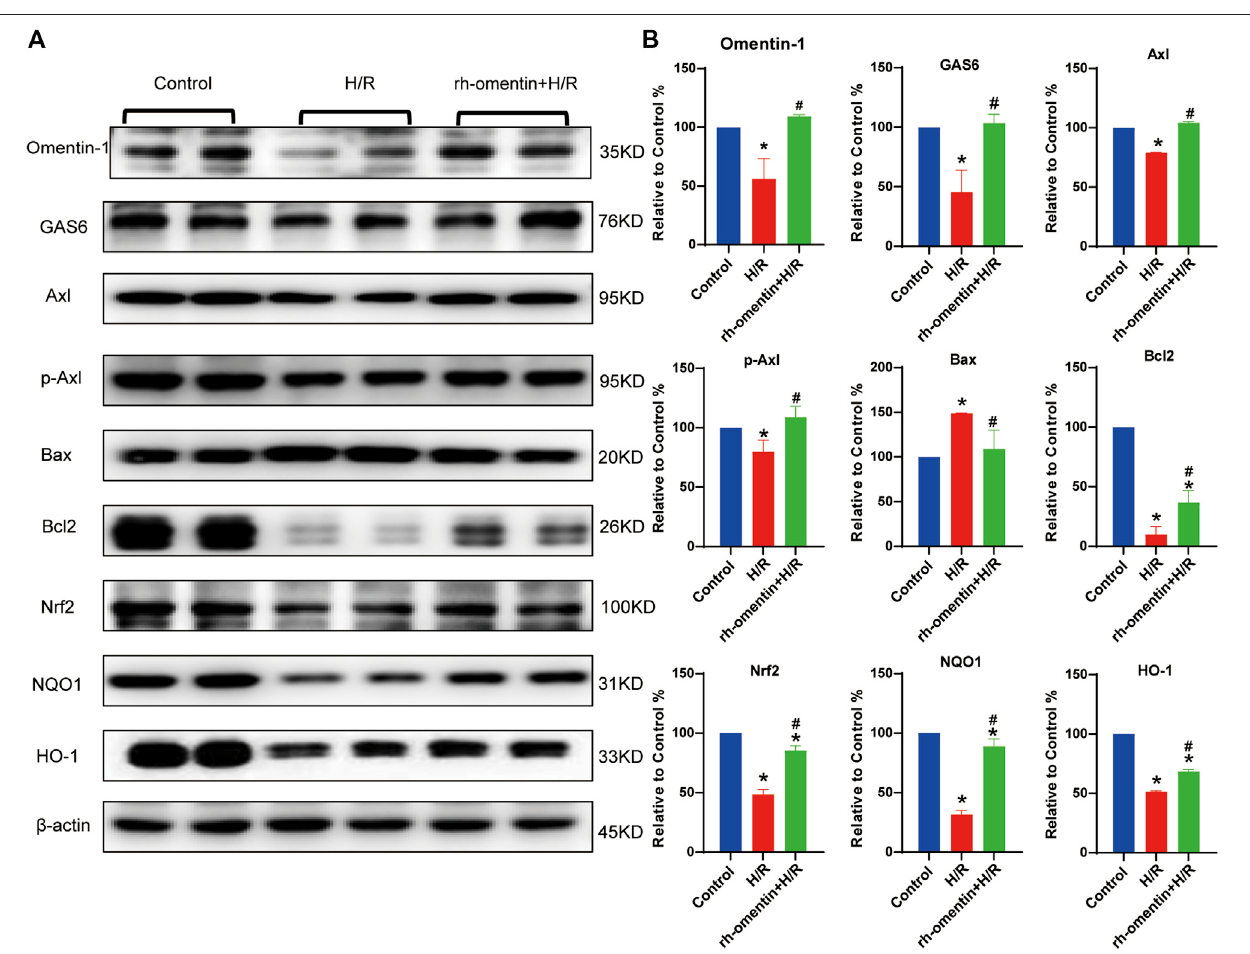
FIGURE 5 | Effect ofrh-omentintreatment onoxidative stressmolecules,apoptotic molecules, and GAS6/Axlsignaling molecules inN2a cells injured byH/R. (A) The representativeimagesofOmentin-1,GAS6,Axl,p-Axl,NQO1,HO-1,Nrf2,Bax,andBcl2detectedbyWesternblot. (B) QuantitativeanalysisofWesternblotbynormalizingto β -actin. Error bars show the standard deviation for n (cid:2) 6 measurements from representative experiments. * p < 0.05 vs. the Control group; # p < 0.05 vs. the H/R group.